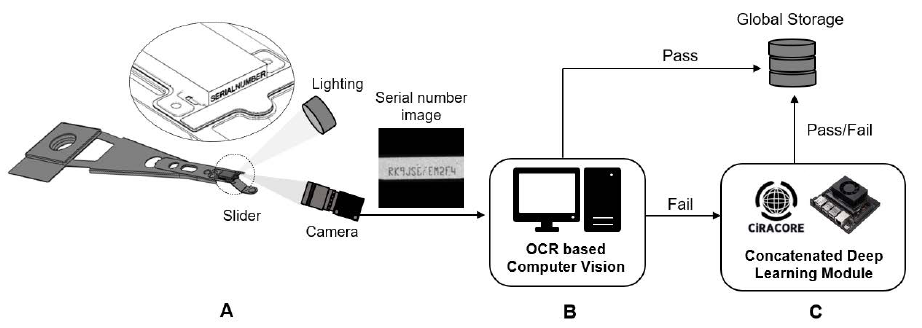
Figure 1. System configuration of the proposed approach for a defect inspection of serial numbers on the slider of HDD. ( A ) OCR image acquisition, ( B ) OCR-based computer vision, and ( C ) OCR-based concatenated deep learning